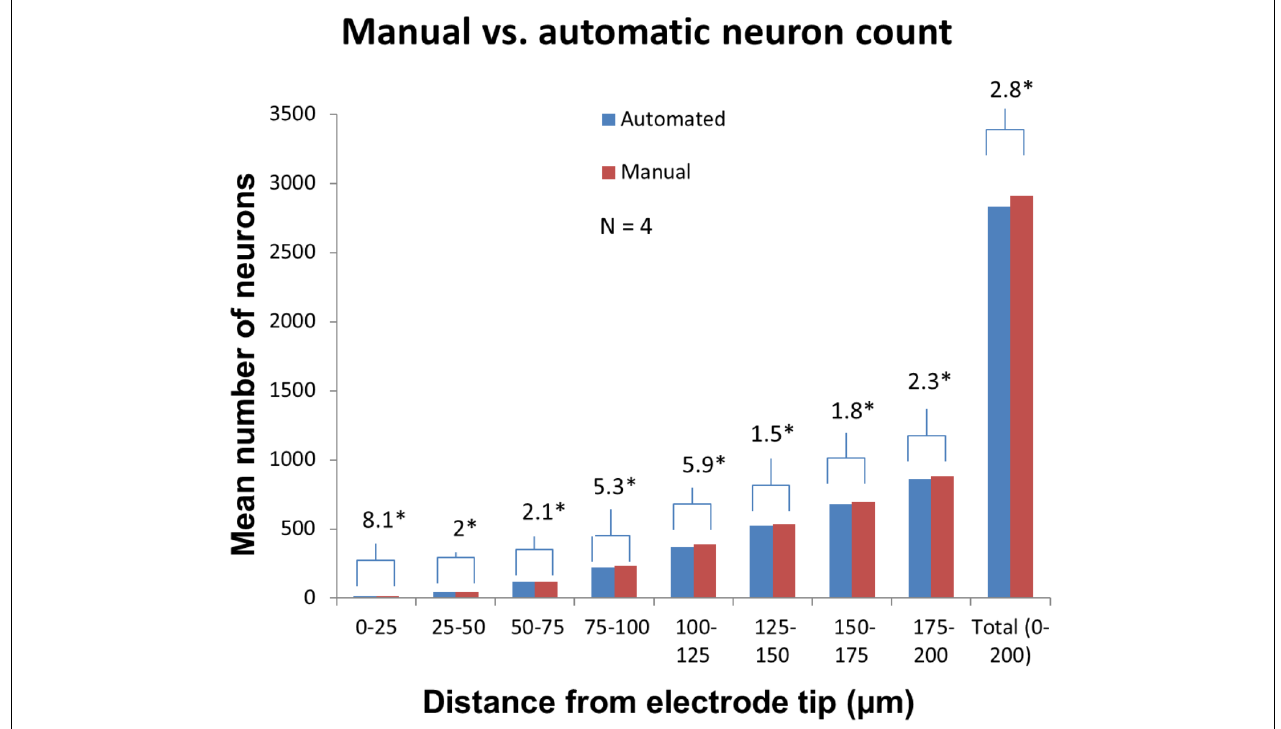
FIGURE 11 | Manual validation of automatic neuron counting protocol. From four electrodes analyzed, on average, manual counting labeled 2.8% more neurons than automatic counting. The greatest errors were seen in the 0–25, 75–100, and 100–125 µ m bins. Asterisk denotes statistical significance ( p < 0.05) using one-tailed paired t -tests.